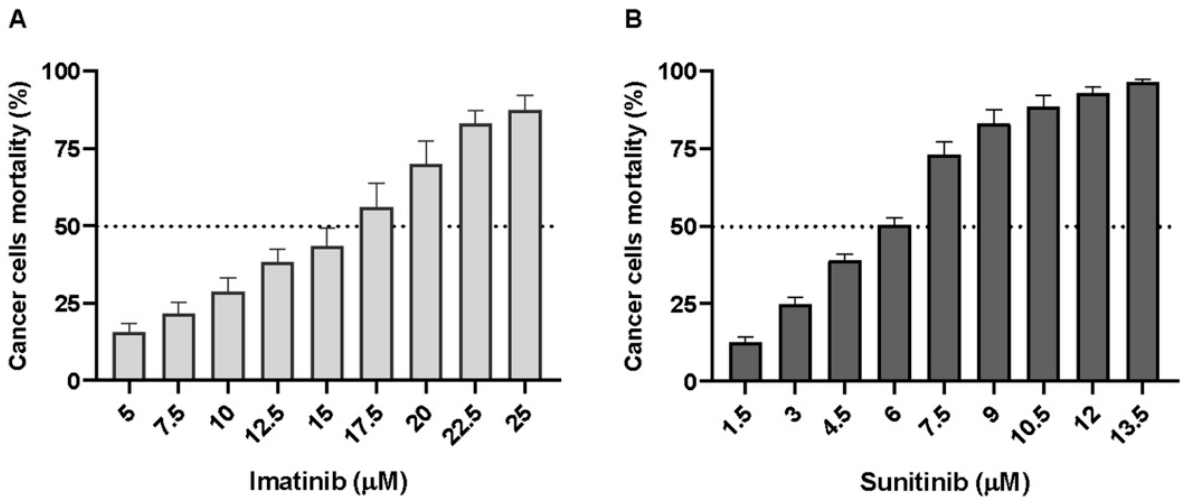
Figure 3. Sensitivity to imatinib and sunitinib of wtGISTc in vitro. wtGISTc resulted resistant to imatinib (IC50 17 ± 8 µ M, mean ± SEM) ( A ) and moderately sensitive to sunitinib (IC50 6 ± 2 µ M, mean ± SEM) ( B ). A498 RCC line was used as a positive control of sunitinib sensitivity.